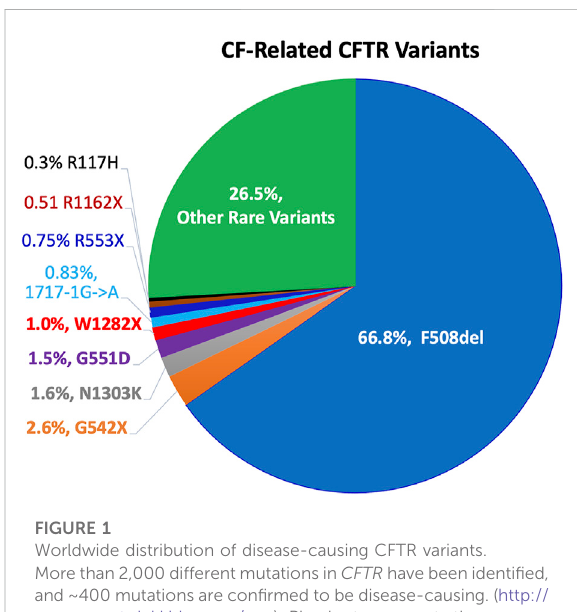
FIGURE 1 Worldwide distribution of disease-causing CFTR variants. More than 2,000 different mutations in CFTR have been identi fi ed, and ~400 mutations are con fi rmed to be disease-causing. (http:// www.genet.sickkids.on.ca/app). Pie chart represents the frequencies of common CF mutations ( > 0.3%) in population worldwide. Notably, the distribution and frequency of CFTR variants vary in different countries and ethnic